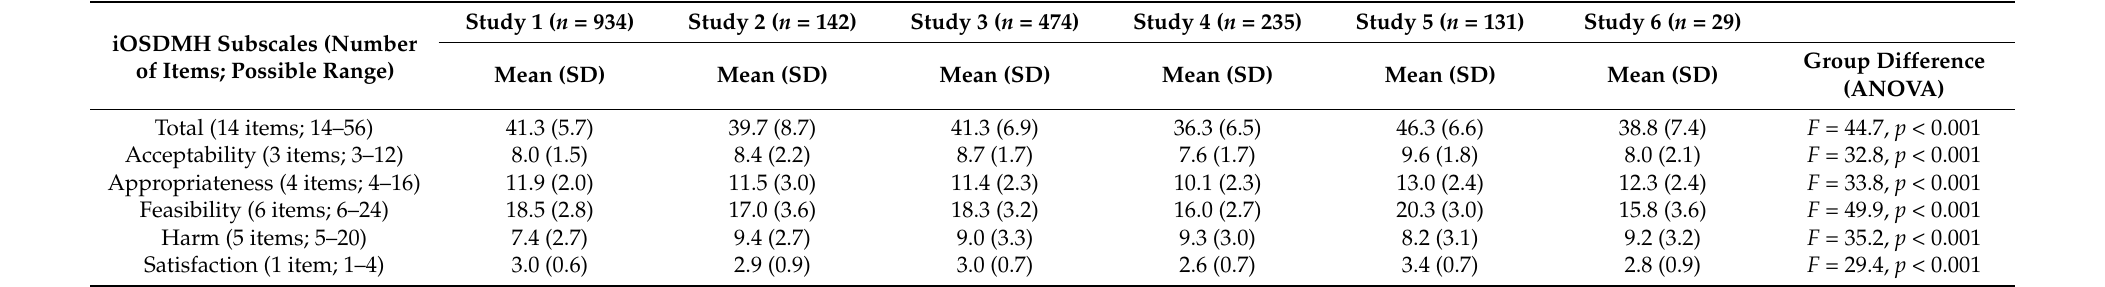
Table 3. iOSDMH Scores and